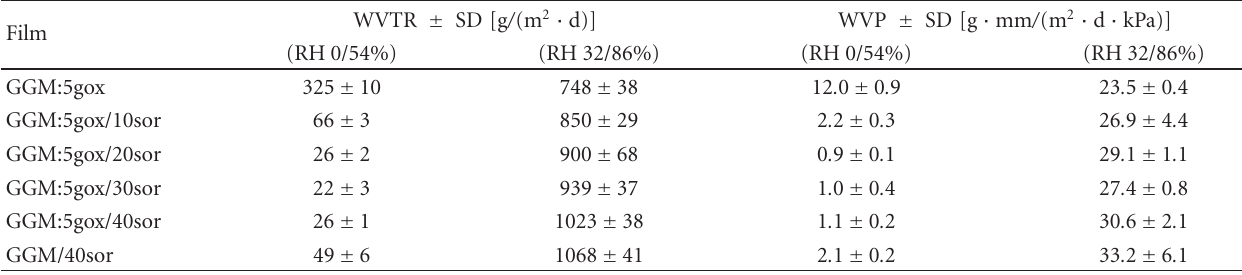
Table 3: Water vapor transmission rate (WVTR) and water vapor permeability (WVP) of films (mean ± standard deviations from three measurements). Sample coding as presented in Table 1.